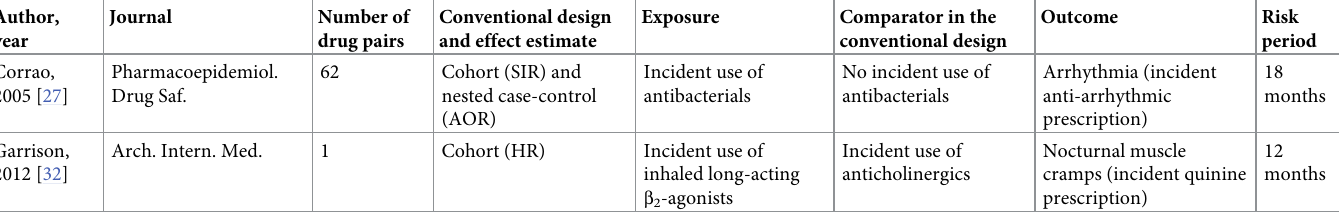
Table 1. Main characteristics of articles included in this